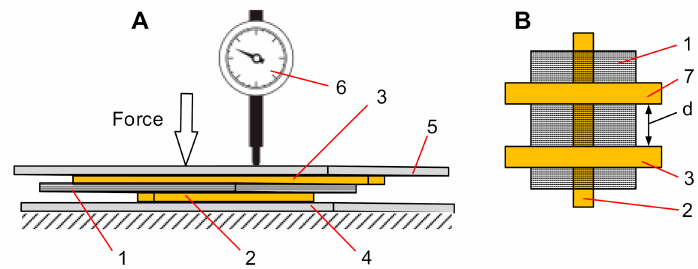
Figure 2. ( A ) Test rig system for the displacement dependence on compressive force measurements, where: 1—pressure-sensitive conductive composite material—Velostat ® , 2—bottom electrode, 3—permanent top electrode, 4—test rig frame, 5—top plate, 6—indicator. ( B ) Test structure, which was used for the displacement dependence on compressive force measurements, based on perpendicularly placed electrodes deposited on opposite site of Velostat ® , where: 7—movable top electrode,